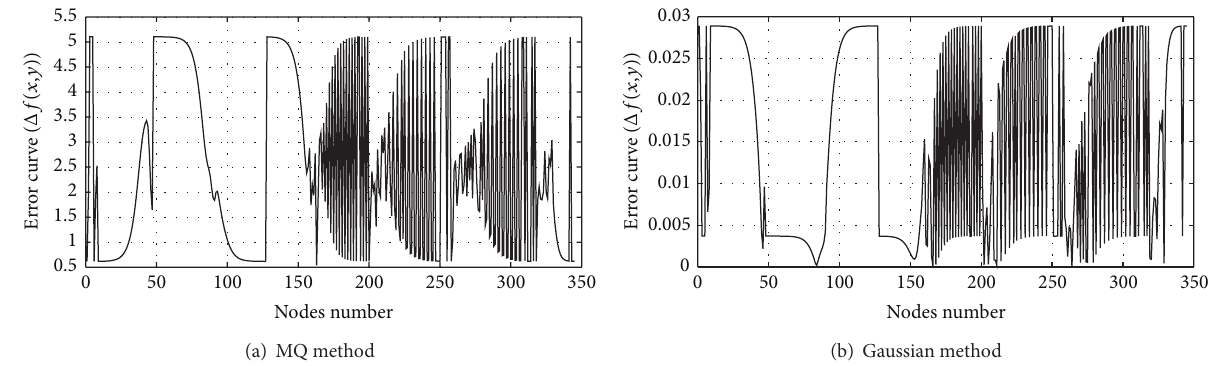
Figure 7: The absolute error curves for MQ method and Gaussian